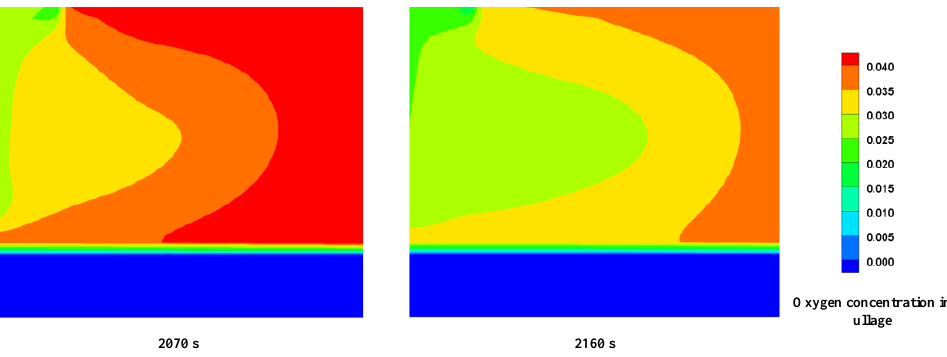
Figure 6. Air flow rate of vent during tactical descent. Nitrogen is injected into the ullage during the entire period of tactical descent, and the oxygen concentration decreases. Taking the initial fuel load of 30% as an example, the oxygen concentration distribution in the ullage at different times in the tactical descent stage is shown in Figure 7, and the oxygen concentration in ullage is expressed as a volume fraction. The lower part of the tank is fuel, which is in the liquid state. Therefore, the oxygen concentration in ullage is zero, which is shown in blue. The higher the concentration in ullage, the redder the cloud image color in Figure 7.